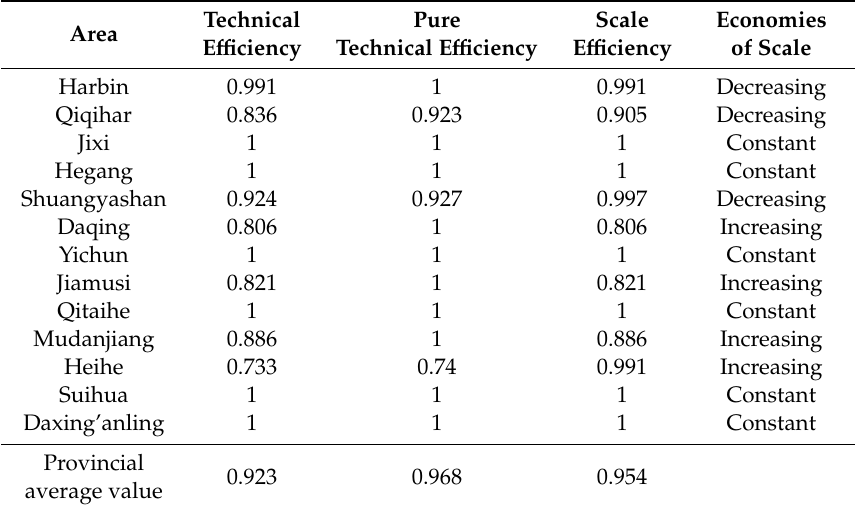
Table 3. Grain production e ffi ciency of cities in Heilongjiang Province in 2015. Technical Area E ffi ciency